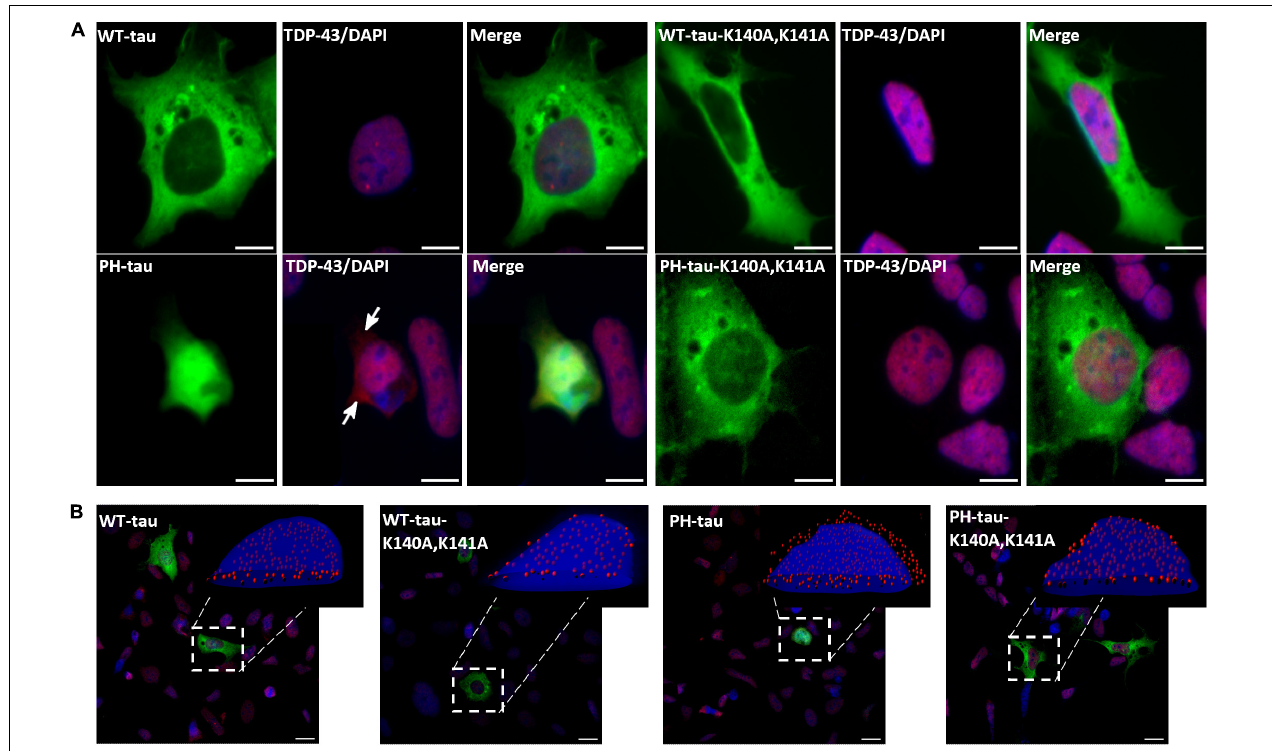
FIGURE 5 | PH-tau-positive cells present mislocalization of TDP-43 to the cytoplasm when PH-tau can enter the nucleus, but not when it is kept in the cytoplasm. (A) HEK-293 cells were transfected with WT-tau, PH-tau, WT-tau-K140A,K141A, or PH-tau-K140A,K141A (green) and immunostained for TDP-43 (red). The localization of TDP-43 was determined by looking for co-localization of the TDP-43 stain and DAPI (blue), which presents as purple. The arrows indicate areas of red staining that do not co-localize with DAPI, indicating mislocalization to the cytoplasm. Scale bar indicates 15 µ m. (B) Overlays of z-stack images taken with a confocal microscope. The inset displays an IMARIS reconstruction of the indicated cell to better display the nuclear or cytoplasmic localization of TDP-43 (red dots). Scale bar indicates 15 µ